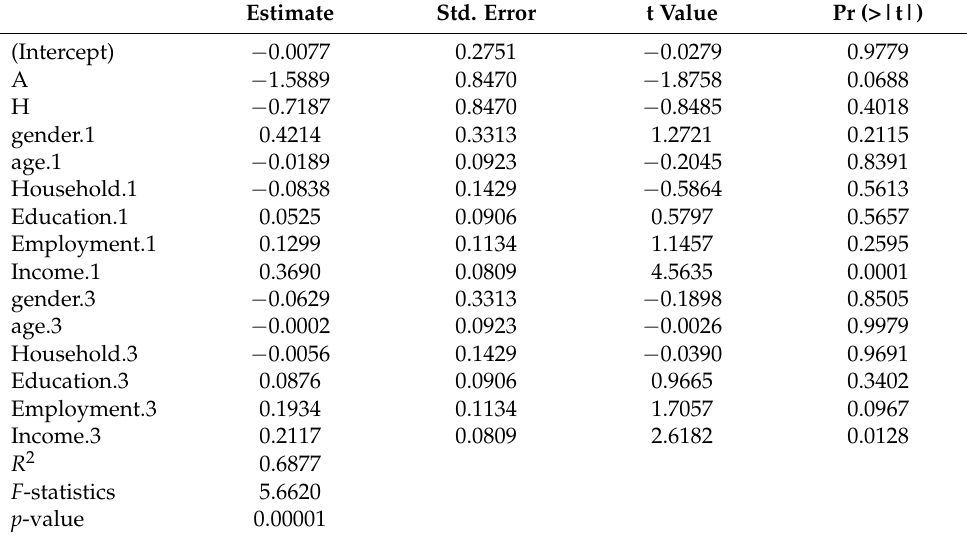
Table 3. Model of regression for AHP priority with demographic